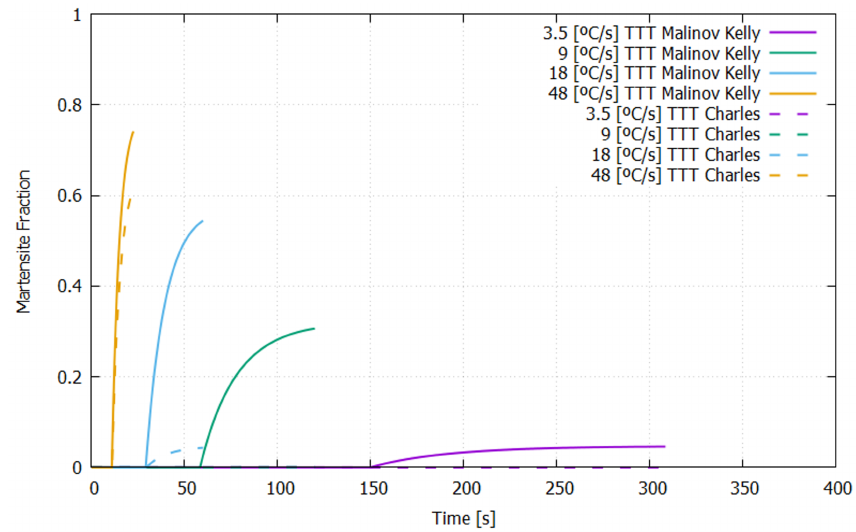
Figure 7. Martensite fraction evolution during continuous coolings. Comparison between results obtained with TTT proposed by Charles et al. [10] and with TTT obtained by a mix of Malinov’s [26,27] and Kelly’s [9] data.